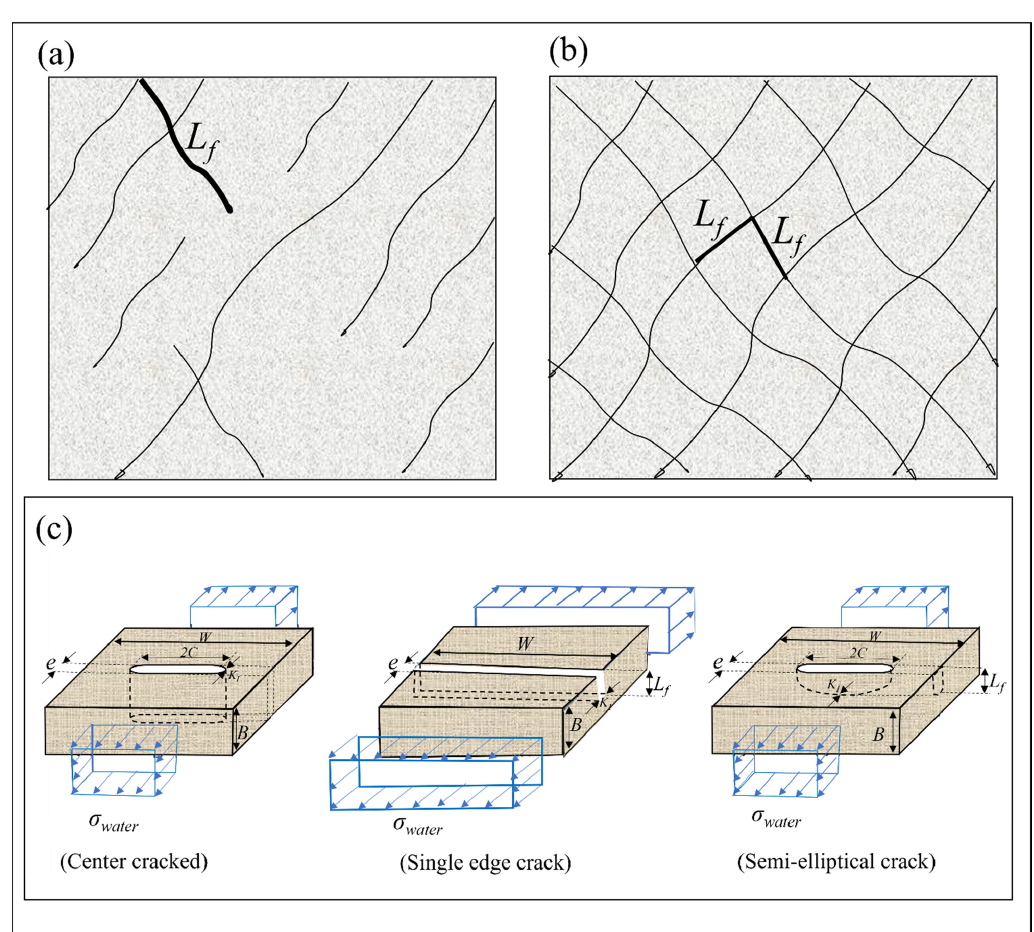
Figure 10. Encountered rock mass layer circumstances for ( a ) irregularly and ( b ) totally jointed rocks; ( c ) proposed structure for the essential geometrical designs of the discontinuously jointed rock [59].